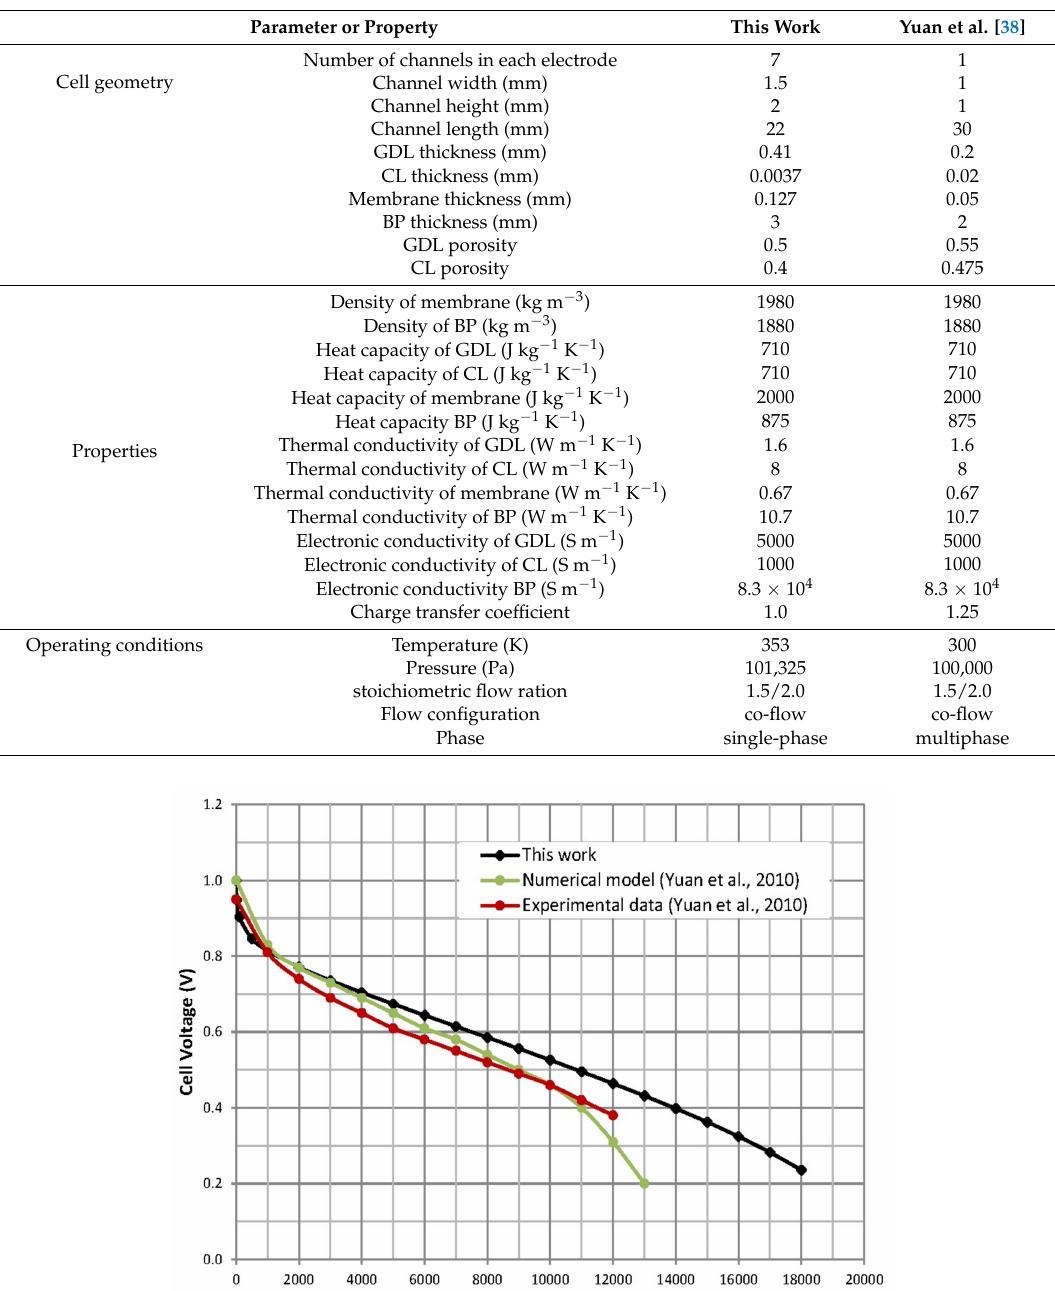
Table 8. Comparison of geometry and properties of present model with Yuan et al. [38] work.